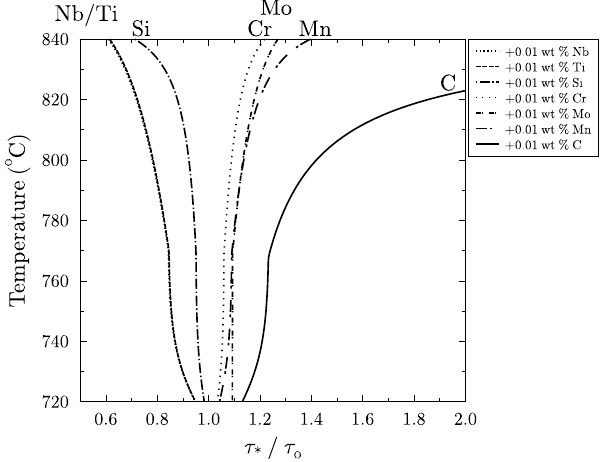
Figure 8. The effects of altering different alloying elements on the phase transformation start at different temperatures for fully recrystallized steel (deformation schedule a) is shown by calculating the fraction τ ∗ / τ o (see text). The plots were calculated from the difference in the ideal TTT start times for steel “TH16” shown in reference [22] (0.09 C, 0.28 Si, 1.53 Mn, 0.012 P, 0.005 S, 0.03 Al, 0.05 Cr, 0.05 Cu, 0.035 Nb, 0.04 Ni, 0.02 Ti, and 0.05 V wt